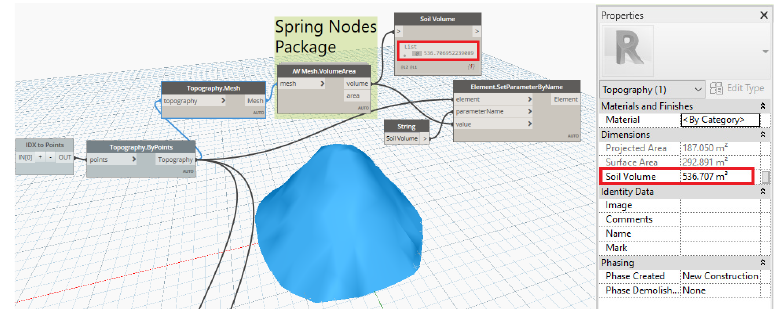
Figure 11. Calculating the soil volume and updating the model’s parameter.